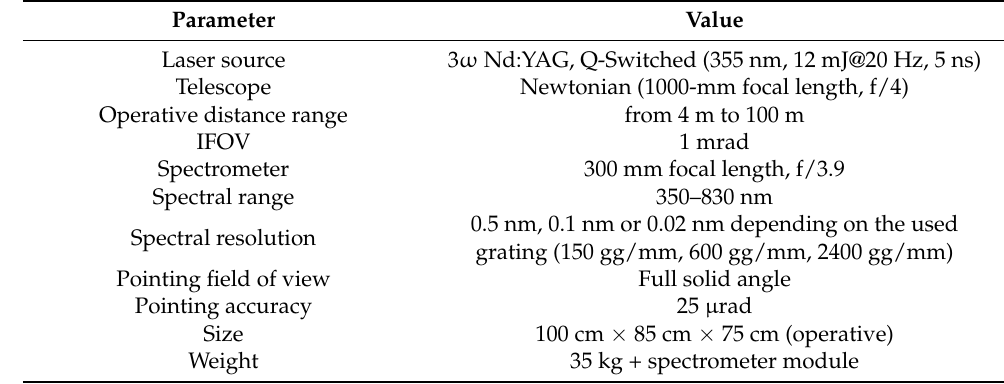
Table 2. Main technical data of the fluorescence LIDAR system.